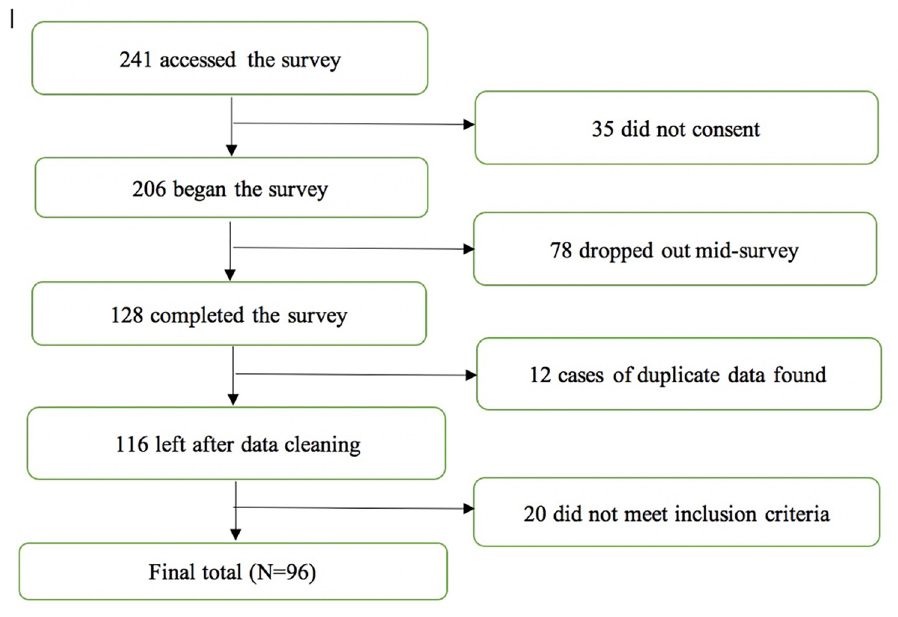
Fig 1. Flow diagram of participation in the